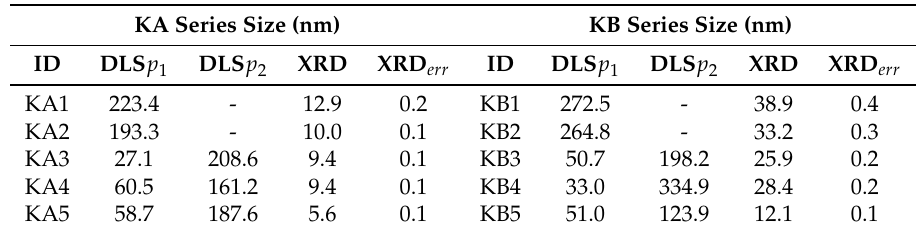
Table 2. Hydrodynamic size obtained from dynamic light scattering (DLS) measurements and average crystalline domain size calculated from XRD